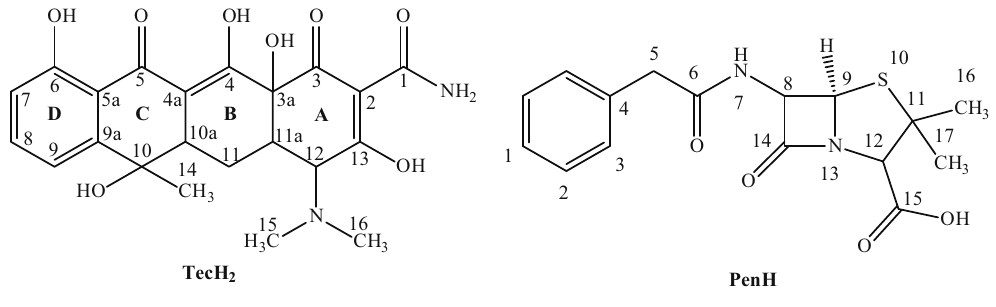
Scheme 1: Molecular diagram of TecH 2 and